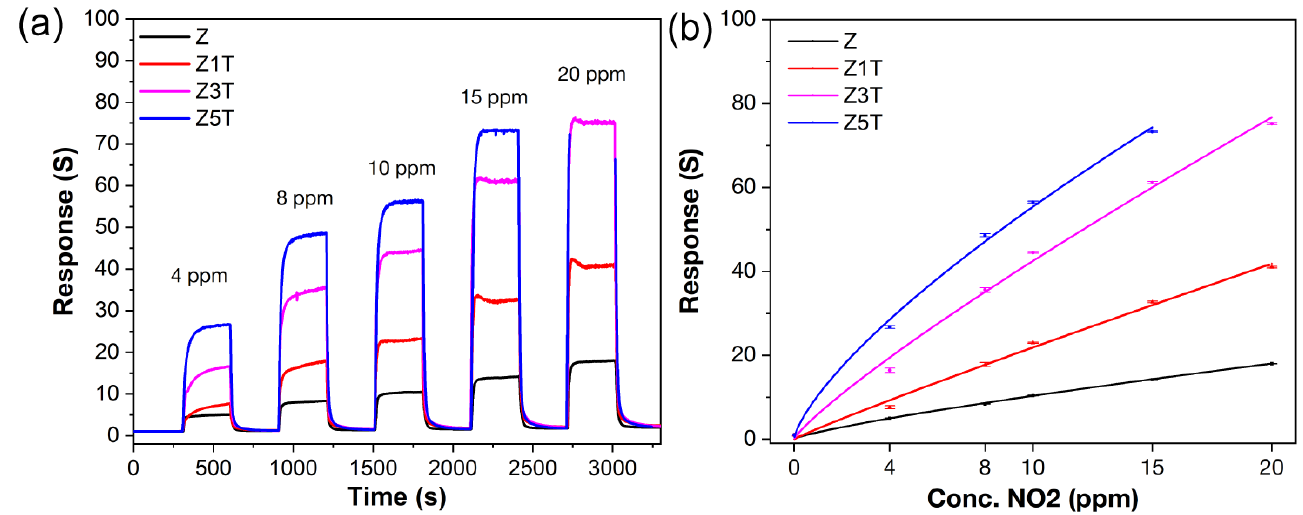
Figure 9. Sensitivity to 4–20 ppm NO 2 ( a ) and response as a function of concentration ( b ) of ZnO/Ti 2 CT x coatings at 200 °C detection temperature.